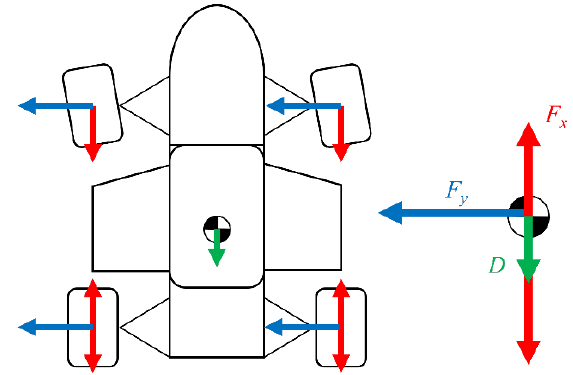
Figure 11. Vehicle model with simple assumptions.